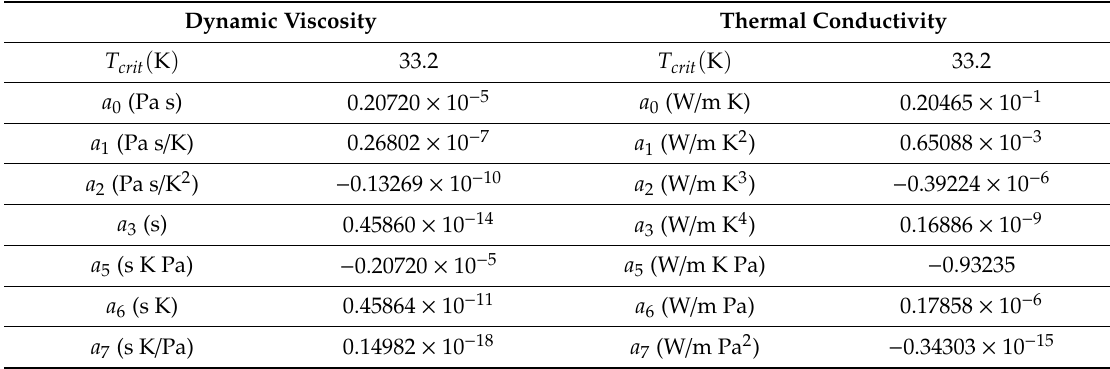
Table 1. Coe ffi cients for the evaluation of helium’s dynamic viscosity and thermal conductivity. [25]. Dynamic Viscosity Thermal